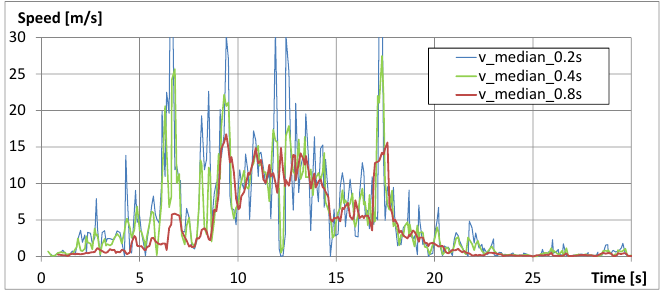
Figure 12. Example rockfall Test 9 showing the horizontally projected velocity over time for different median intervals 0.2 s, 0.4 s and 0.8 s.